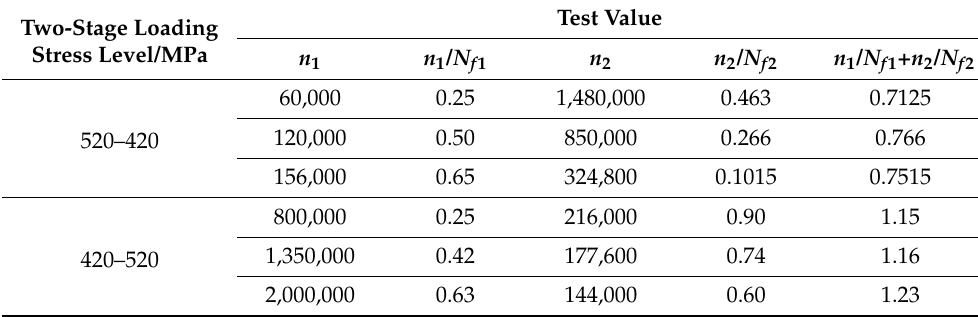
Table 3. 18CrNiMo7-6 two-stage loading test data.